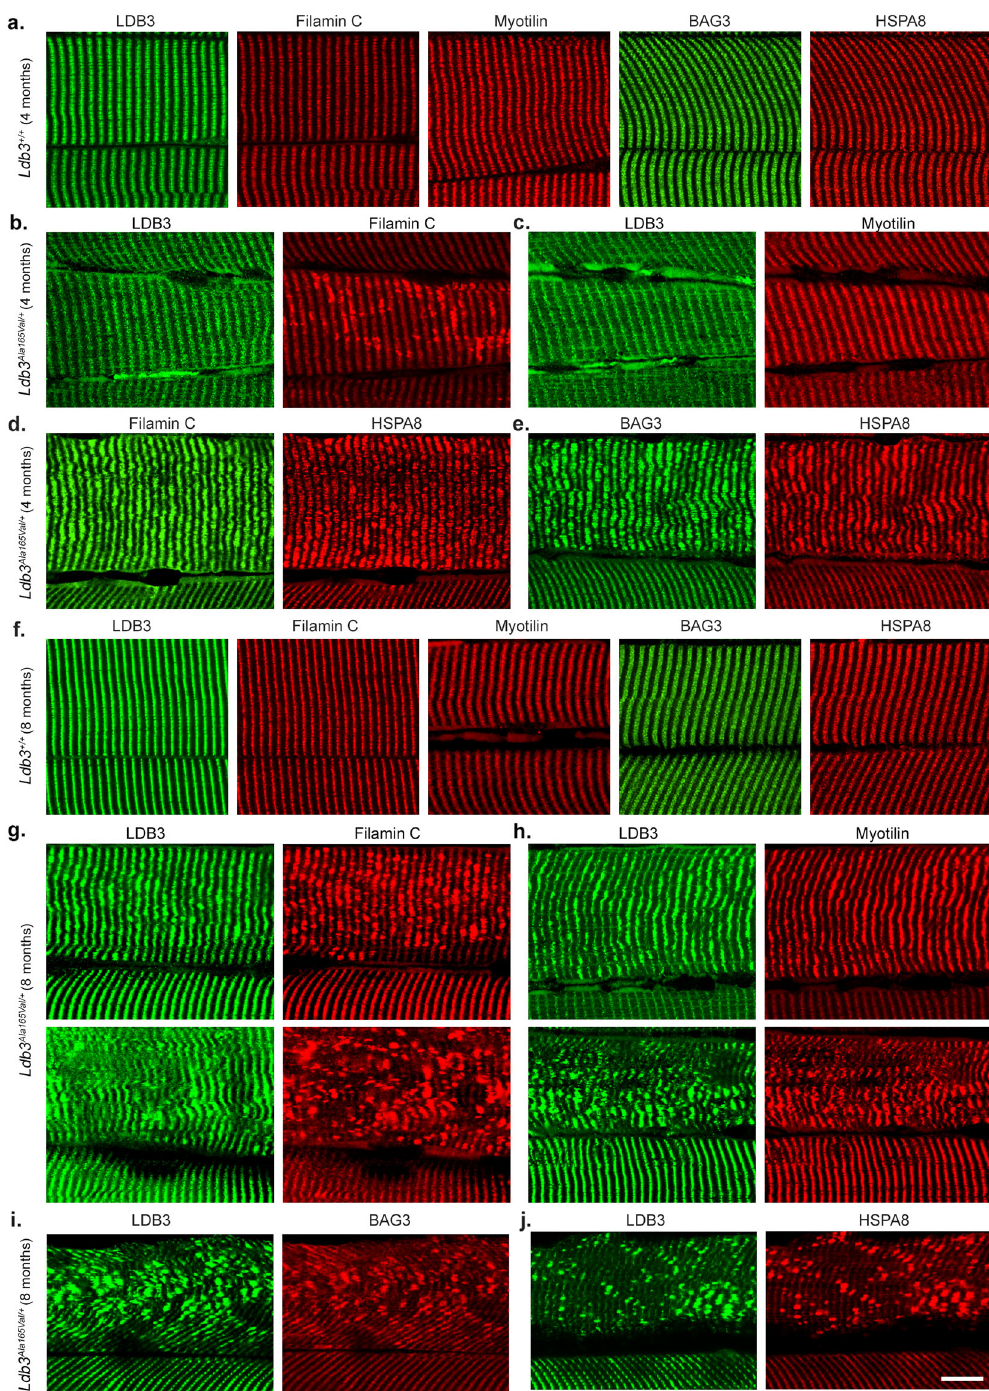
Ldb3 + / + littermates. Whole muscle levels of PKC α in 4- and 8- month-old Ldb3 Ala165Val/ + mice were decreased to about 50% of those in Ldb3 + / + littermates, and levels of TSC2 in the mutant mice were reduced to almost two-thirds of those in Ldb3 + / + mice (Fig. 6c – f; Supplementary Data 8, 9). Downregulation of PKC α and TSC2 indicates a likely mechanism for the observed aggre- gation of damaged fi lamin C in muscle fi bers of Ldb3 Ala165Val/ + mice as PKC α stabilizes fi lamin C in muscle Z-disc through phosphorylation 34 , and TSC2 initiates CASA-mediated degrada- tion of damaged fi lamin through local mTORC1 inhibition 35